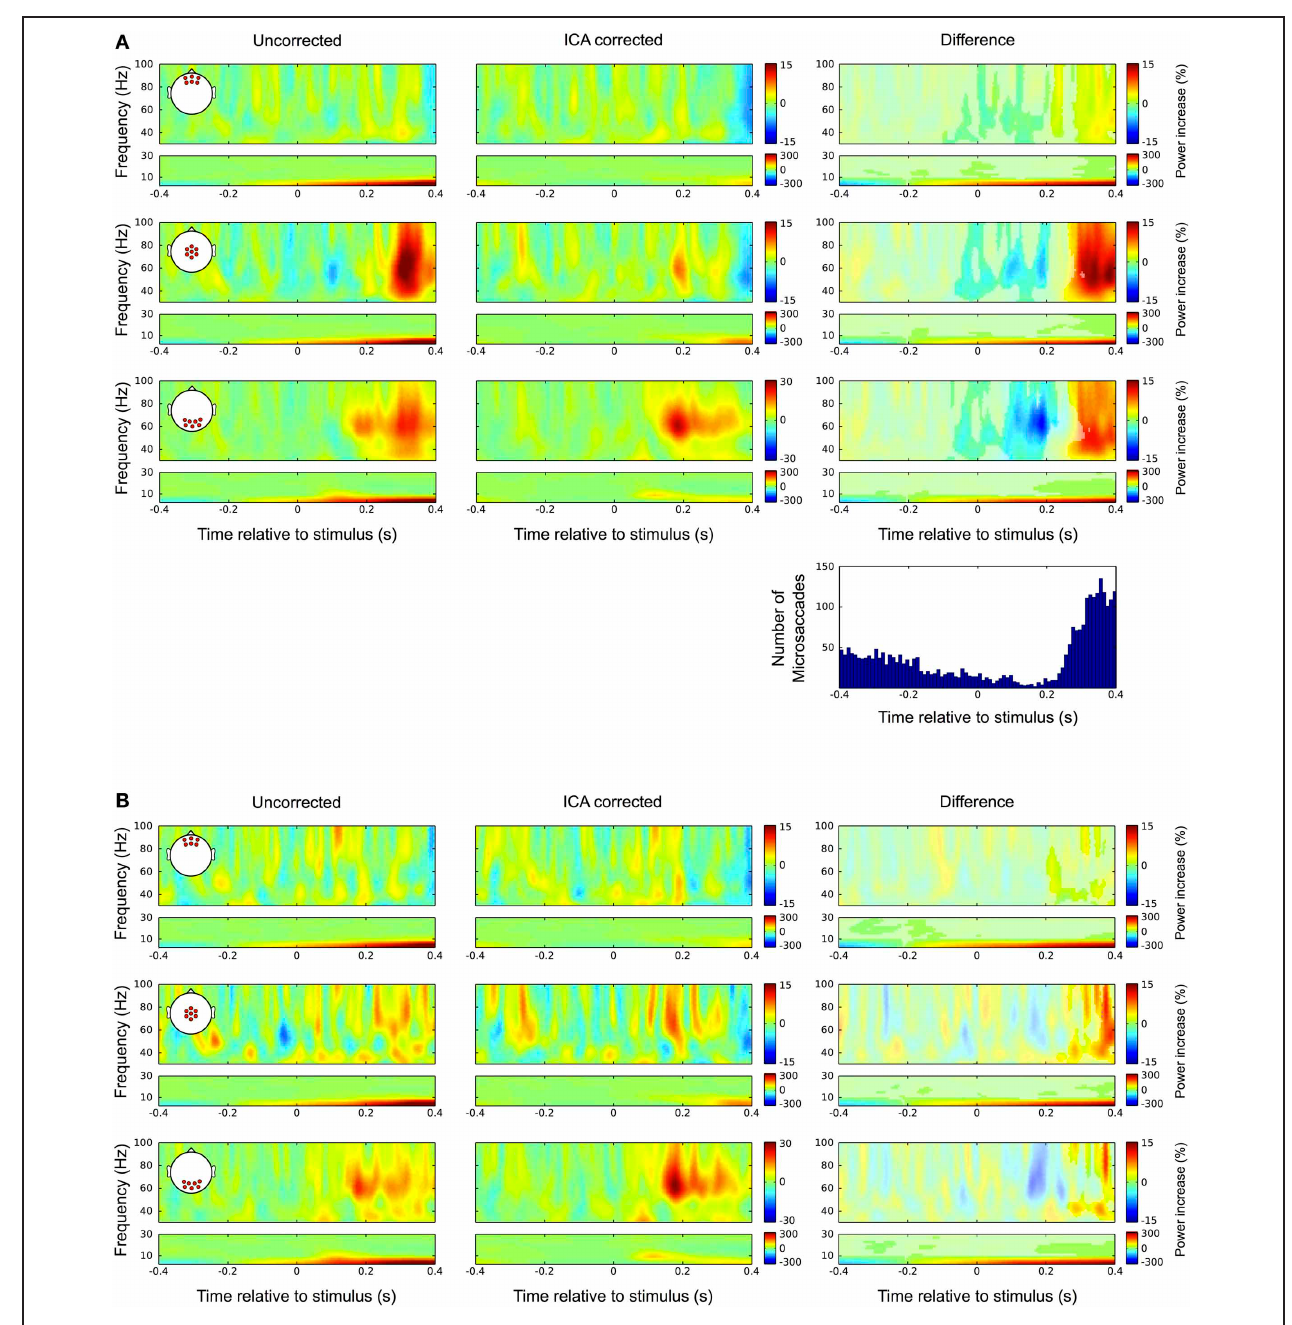
significant portions of the observed differences (i.e., bins in original color; non-significant bins are gray shaded) follow the pattern of microsaccade distribution very closely. The negative gamma power difference after stimulus onset results from a drop in microsaccade rate relative to